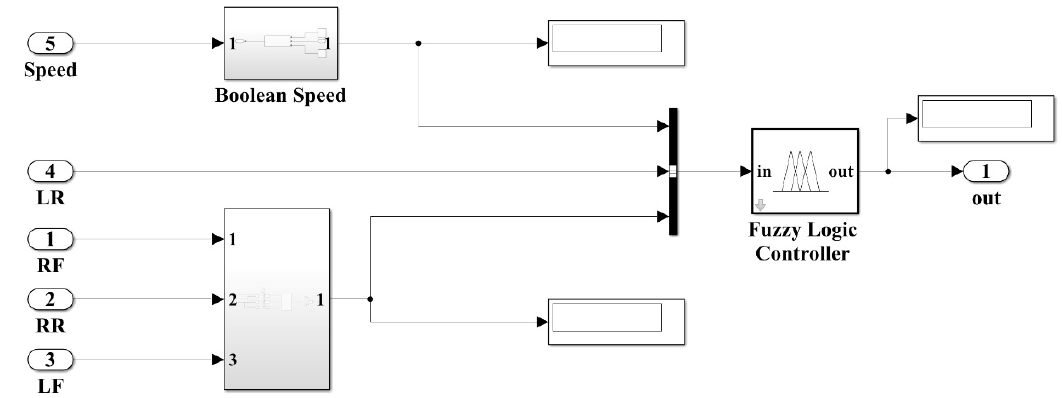
Figure 6. Fuzzy logic controller for estimated slip value calculation.